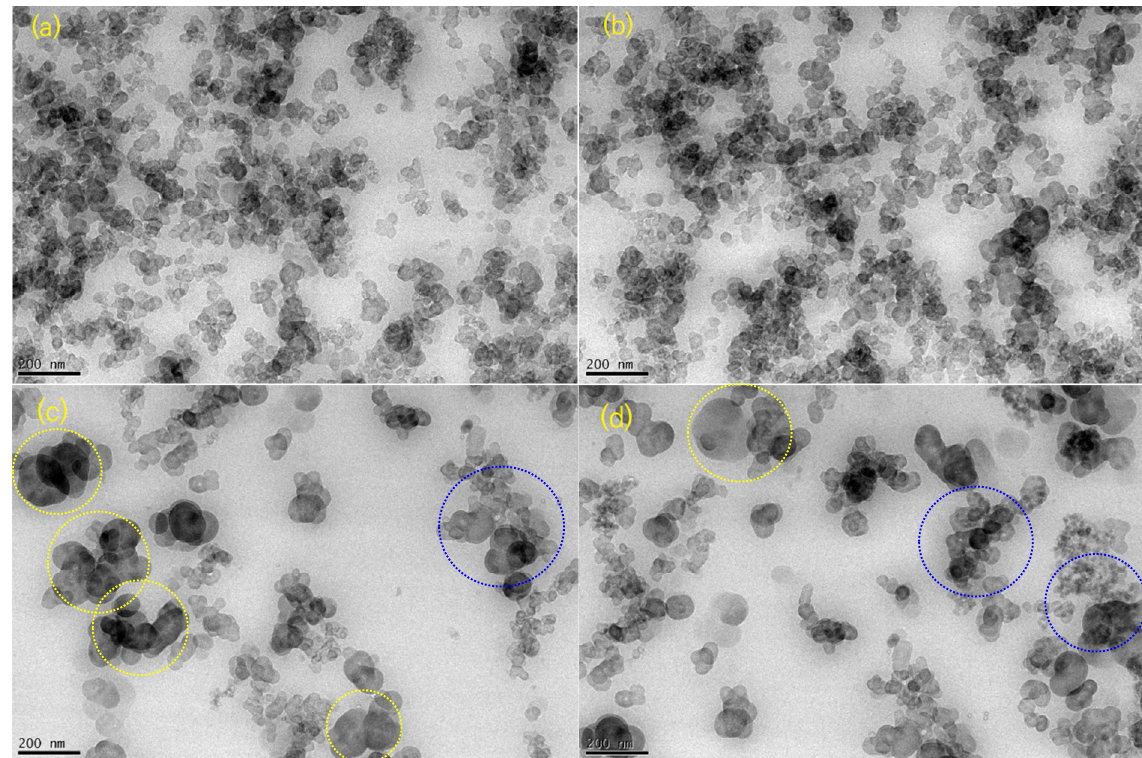
Figure 1. TEM images showing the CB particles (black or gray spherical shape) and aggregates in the peroxide-crosslinked CB-filled EPDM composite with ( a , b ) HAF20 and ( c , d ) SRF20: ( a , b ) are images taken for different parts of the EPDM HAF20 specimen; ( c , d ) are images taken for different parts of the EPDM SRF20 specimen.